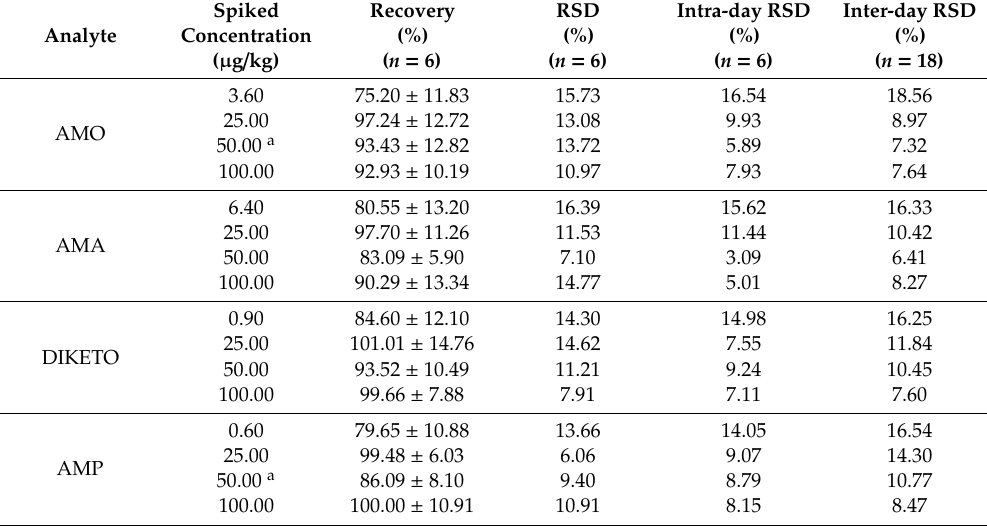
Table 6. Recoveries from and precision of the analysis of AMO, AMA, DIKETO, and AMP spiked in blank liver